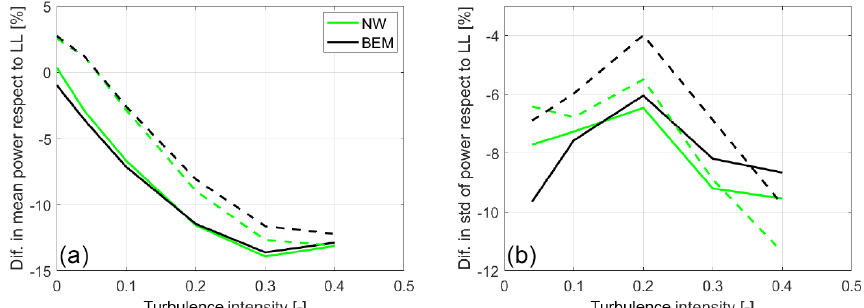
Figure 14. Differences in power in the function of turbulence intensity (a) mean and (b) standard deviation. Solid lines represent the baseline blade, while dashed lines represent the optimized tip design. Table 4. Statistics of the power and flapwise root bending moment predicted in the extreme turbulence case by HAWC2-NW and HAWC2- BEM with respect to HAWC2-LL predictions. The table shows the difference in percentages. Baseline Opt tip LL NW